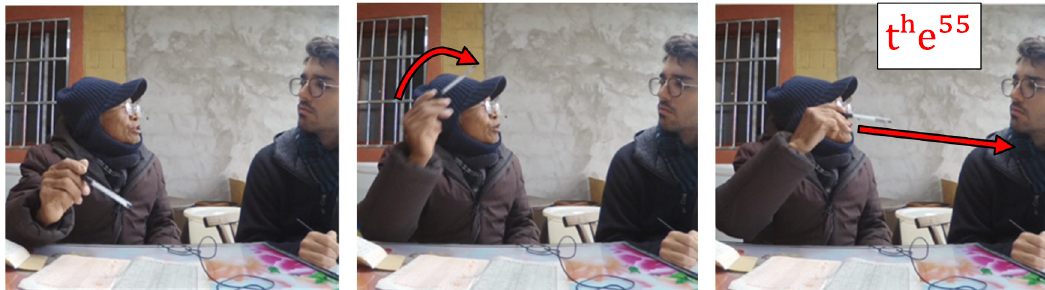
Figure 17: Puncture stroke towards addressee ’ s chest is perfectly co - timed with bolded t ʰ e ⁵⁵ in Example